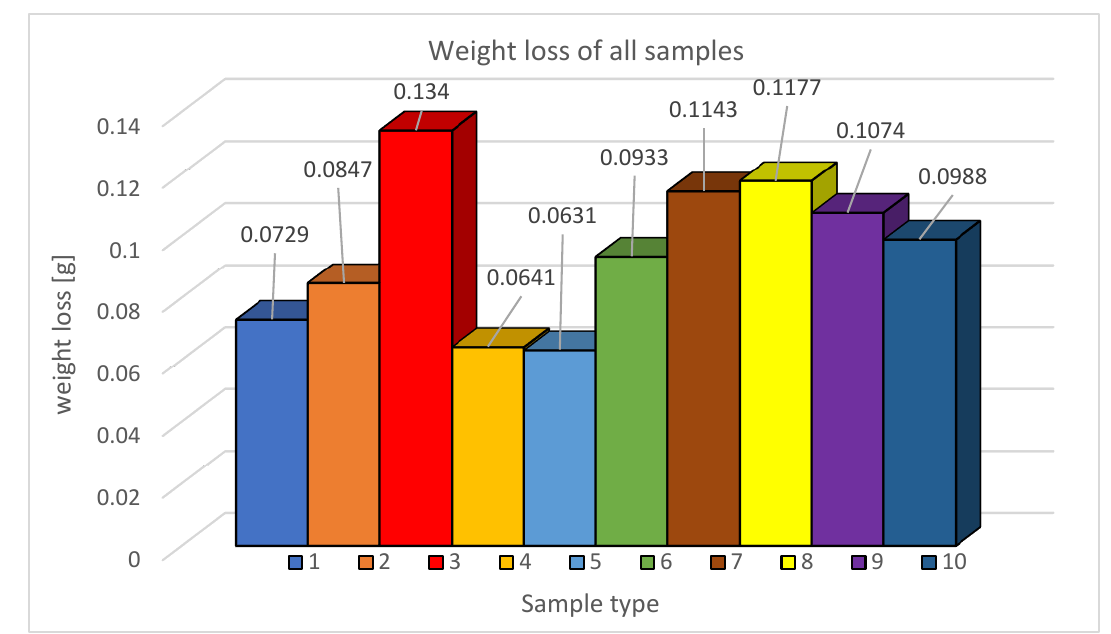
Figure 12. Summary of weight loss in all samples (Samples 1 – 5 X-orientation and Samples 6 – 10 Z-orientation).